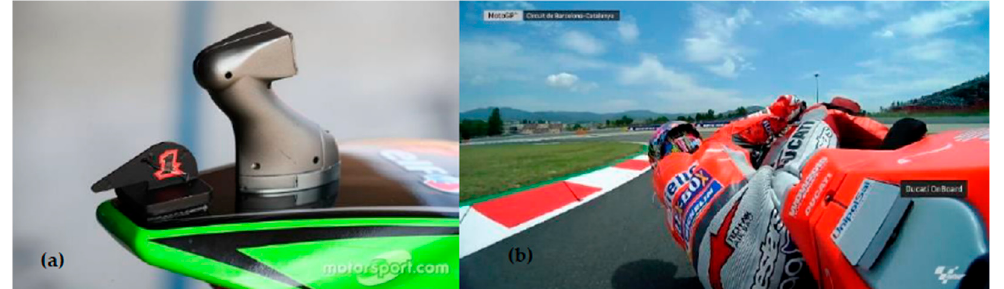
Figure 1. ( a ) Gyroscopic camera; ( b ) rear shot with gyroscopic camera.